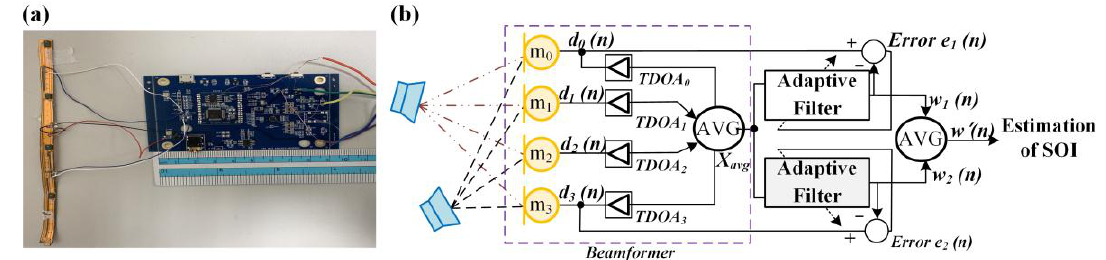
Figure 5. ( a ) Four-array microphone and beamforming module pictures; ( b ) System block